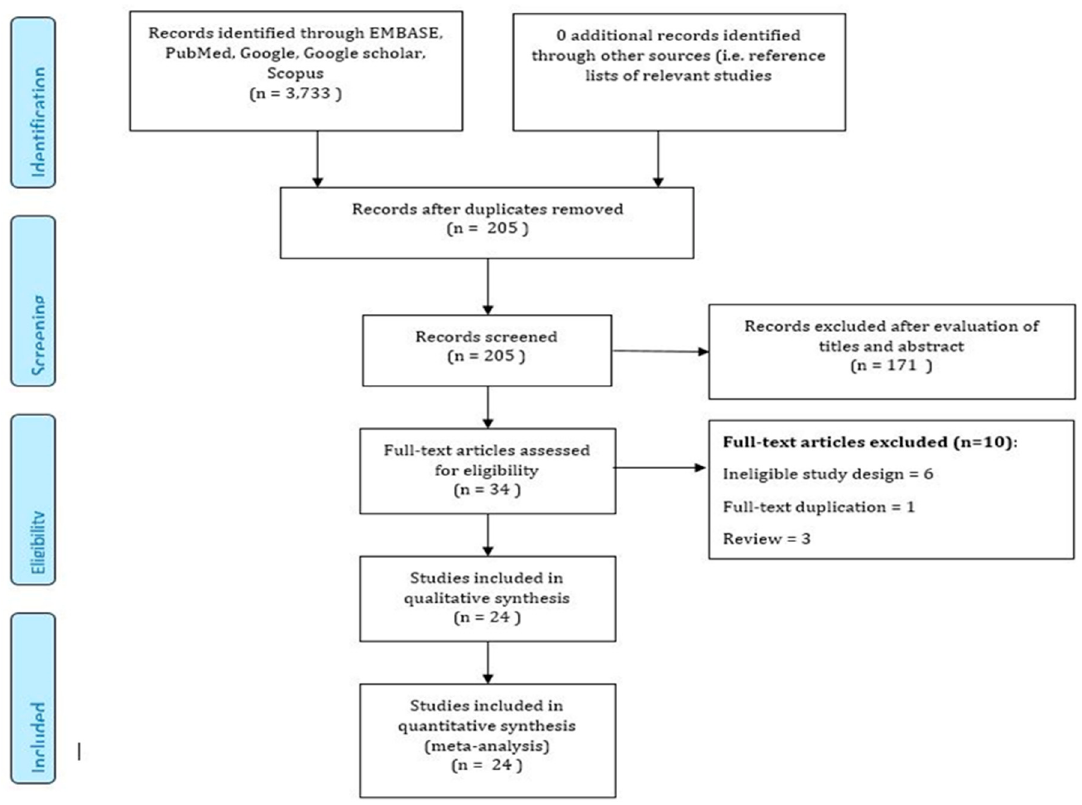
Figure 2. PRISMA (Preferred Reporting Items for Systematic Reviews and Meta-Analyses) flow diagram for study selection.